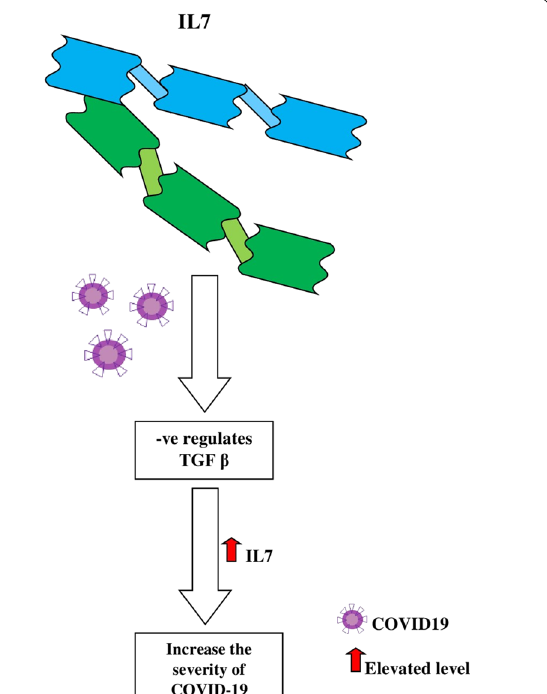
Fig. 8 The severity of SARS-CoV-2 due to the interleukin-7